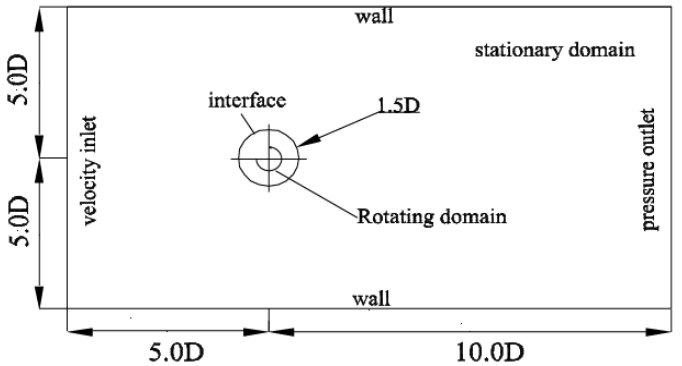
Figure 6. Computational domain diagram of wind turbine.